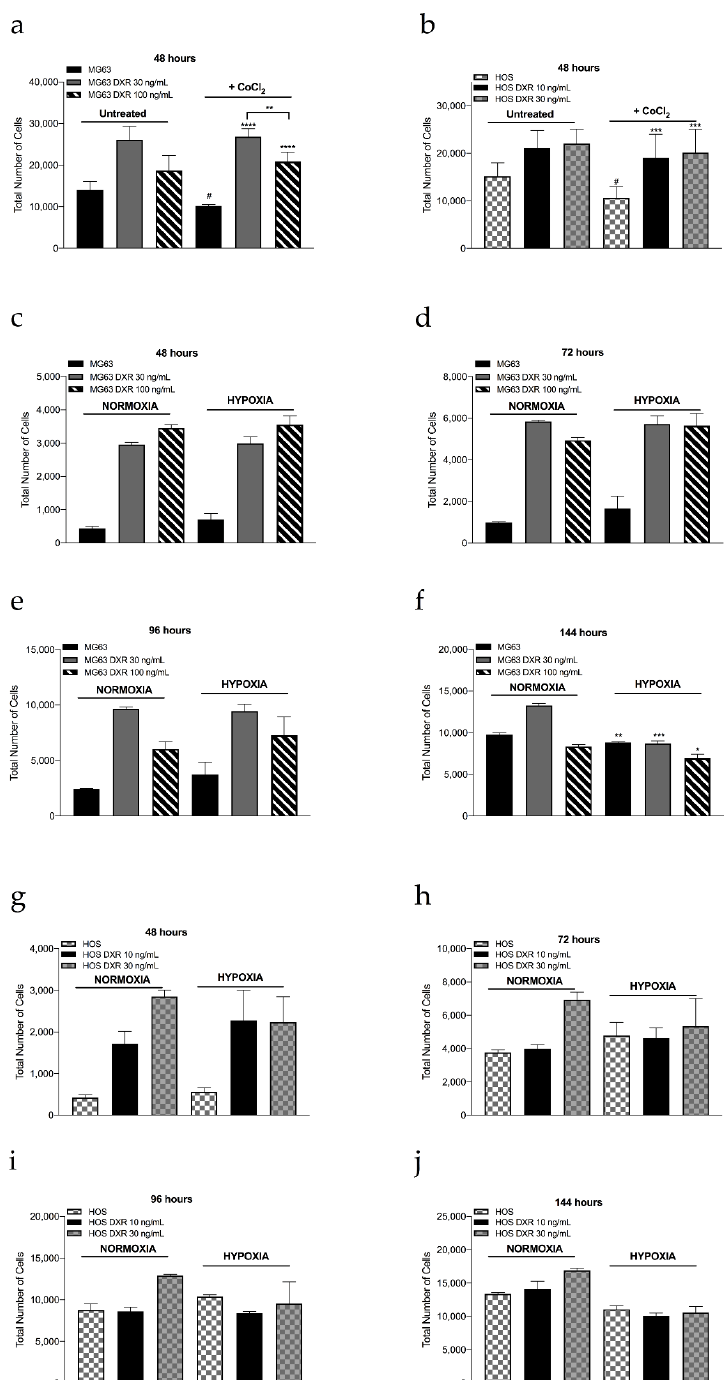
Figure 5. Analysis of cell growth of sensitive and resistant clones under hypoxia for various exposure times. We counted the total number of MG63, MG63 DXR 30 ng/mL, and MG63 DXR 100 ng/mL cells ( a , c – f ) and HOS, HOS DXR 10 ng/mL, and HOS DXR 30 ng/mL cells ( b , g – j ) after CoCl 2 ( a , b ) low O 2 tension (2%) ( c – j ) treatments by Hoechst 33258 staining with automated cell count system and at different time points, 48 ( a – e ), 72 ( b – f ), 96 ( c – g ), and 144 h ( d–h ). Data represent mean ± SD of four-eight different experiments. * p < 0.05, ** p < 0.01, *** p < 0.001, hypoxia vs. normoxia conditions; # p < 0.05, CoCl 2 vs. untreated conditions, *** p < 0.001, **** p < 0.0001, resistant vs. sensitive clones after CoCl 2